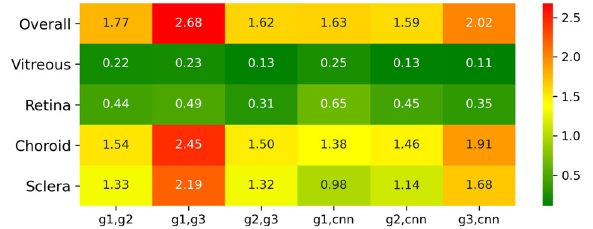
Fig. 1 Heatmap table of the test set grading variability. The deviations are shown in percentage (%) between human graders (g1 – g3) and the CNN with regard to the ocular compartments. The percentages are equivalent to the Hamming distance and represent the difference in labeled pixels between two gradings. In particular, the inter-human grader variability and the variability between the human graders and the CNN are shown. The overall average inter-human grader variability between (g1, g2), (g1, g3) and (g2, g3) was 2.02% and 1.75% between the CNN and the human graders, i.e., (g1, cnn), (g2, cnn), and (g3, cnn). Overall, the results of grader g2 and g3 were most similar, followed by the differences in the gradings of g2 and g1. The segmentation of grader g1 and g3 differed most. When comparing the segmentations of the human graders and the CNN, the Hamming distance increased from CNN compared to g2, to CNN compared to g1 to CNN compared to g3. Regarding individual compartments, agreement in vitreous and retina are higher than in sclera and